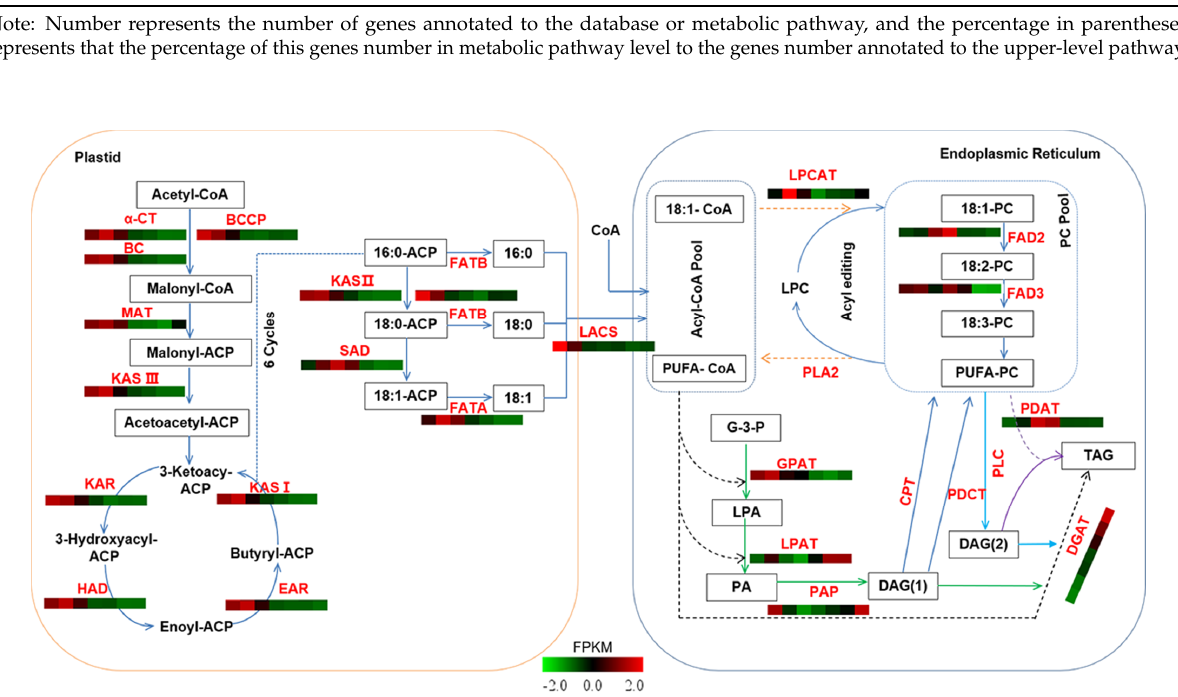
Figure 3. Metabolic pathways and gene expression patterns of oil accumulation during seed development of A. sphaerocephala . Note: The seven colored boxes in each horizontal row correspond to the seven developmental stages. The expression level of each gene in the heatmap is the sum of the FPKM of all DEGs encoding the enzyme. The color scale indicates the expression levels (represented by the log 2 FPKM) of genes. The dotted line represents acyl flux, the green line represents the Kennedy pathway (acyl-CoA dependent pathway), the purple line represents the acyl-CoA independent pathway, the orange line represents acyl editing, and the blue represents PC-derived DAG synthesis, DAG (1) represents the DAG in the de novo biosynthesis, and DAG (2) represents the DAG derived from the PC. Abbreviations: ACCase, acetyl-CoA